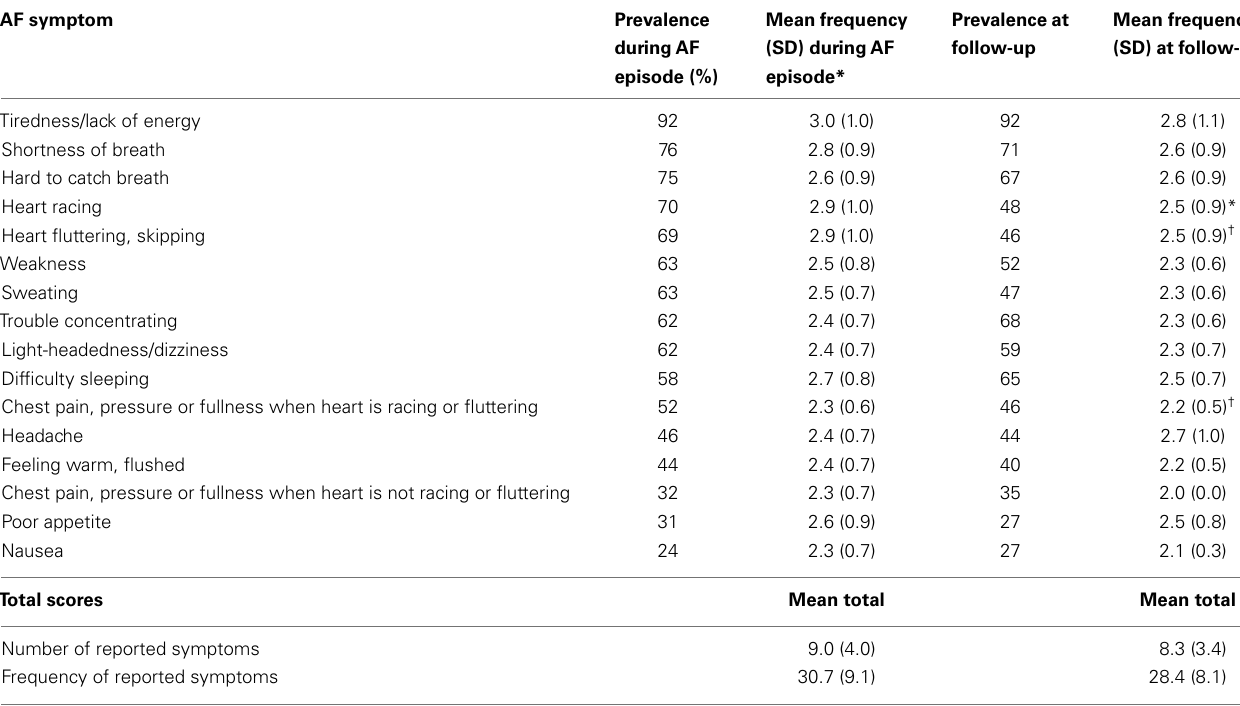
Table 2 | Prevalence and mean frequency of the individual subjectiveAF